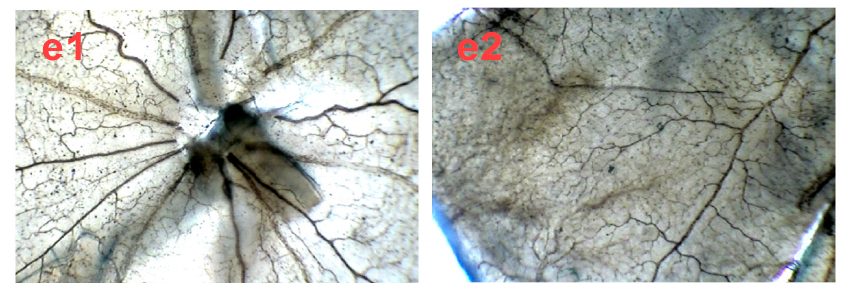
Figure 6. The in vivo effect of SPN and Conbercept on retinopathy of rats in ADPase-stained retinal sections (40×). Central retinal region of rat pups fostered under normoxia conditions ( a1 ); OIR rats intraperitoneally administered with NS ( b1 ), 1.0 mg/kg Conbercept ( c1 ), 5.0 mg/kg SPN ( d1 ) or 10.0 mg/kg SPN ( e1 ). Peripheral retinal region of control, rat pups fostered under normoxia conditions ( a2 ); OIR rats intraperitoneally administered with NS ( b2 ), 1.0 mg/kg Conbercept ( c2 ), 5.0 mg/kg SPN ( d2 ) or 10.0 mg/kg SPN ( e2 ). Ten rats were used for each group ( n = 10).